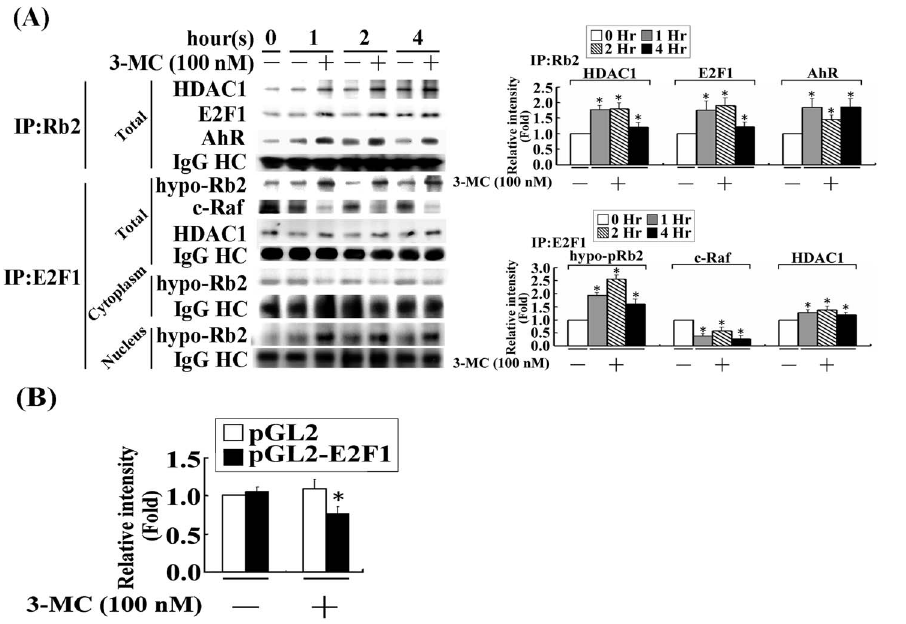
Figure 5. 3MC treatment of MCVECs increased the formation of AhR/c-Raf/pRb2/E2F1/HDAC1 complexes, with a concomitant decrease in E2F-driven luciferase activity. (A) Cells received 1 h of 100 nM 3MC treatment; they were then harvested with subcellular fractionation and immune-precipitated by anti-pRb2 and anti-E2F1 antibodies (2 m g) and by protein A and G agarose beads (20 m L). The resulting immunoprecipitate was detected with anti-AhR, -E2F1, -c-Raf, -HDAC1, and - pRb2 antibodies in Western blot. The samples were normalized to the IgG heavy chain, the corresponding no 3MC signal, and the 0 h time point. (B) MCVECs were transiently transfected with pGL2/E2F and pRL-TK for 24 h, as described in the ‘‘Materials and Methods’’ section. Luciferase activity of the reported plasmid was normalized to that of the internal control plasmid. Data were derived from 3 independent experiments and are presented as mean 6 SEM (* P , 0.05 vs. the control group).